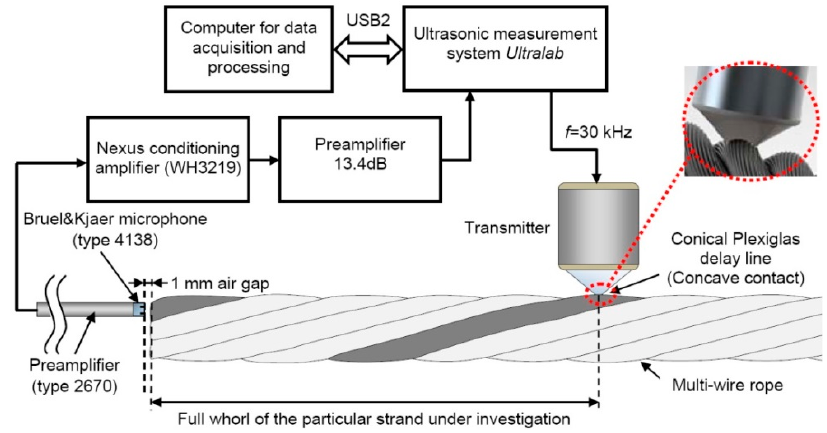
Figure 13. The experimental setup for the investigation of a guided wave propagation in a multi-wire rope.